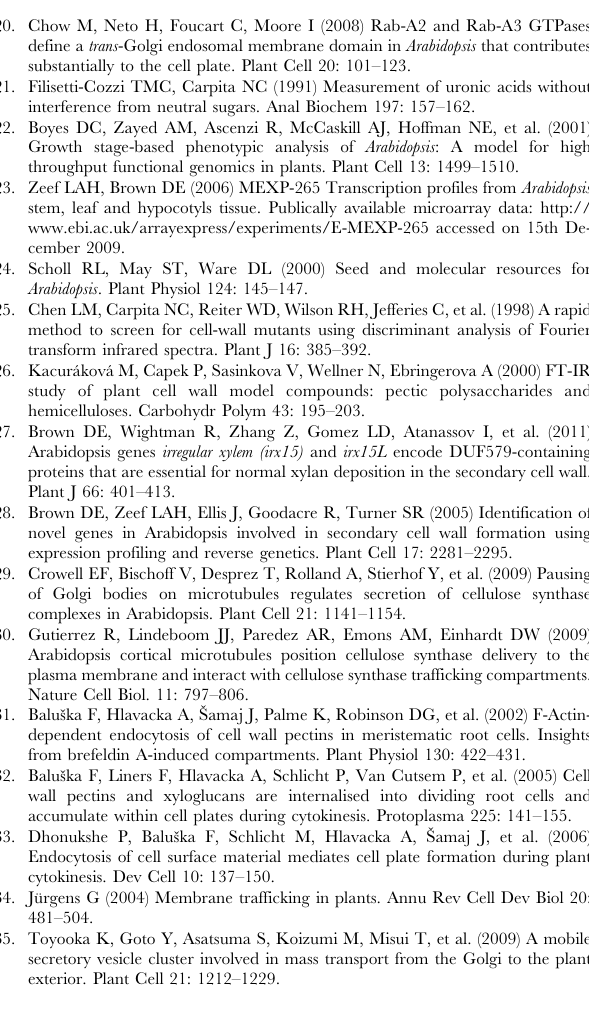
Figure S3 Confirmation of gene transcript absence by RT-PCR analysis of rabA3 T-DNA knockout line. Expect- ed size fragments for each reaction are shown in table S2. Key to lanes: M, Marker; 1, wild type RAB gene expression; 2, No RT; 3, RAB gene expression in insert line; 4, Actin expression in insert line. (TIF) Figure S4 Confirmation of gene transcript absence by RT-PCR analysis of rabA2 T-DNA knockout lines. Expected size fragments for each reaction are shown in table S2. Panel A= rabA4a, Panel B= rabA4b Panel C= rabA4e. Key to lanes: M, Marker; 1, wild type RAB gene expression; 2, No RT; 3, RAB gene expression in insert line; 4, Actin expression in insert